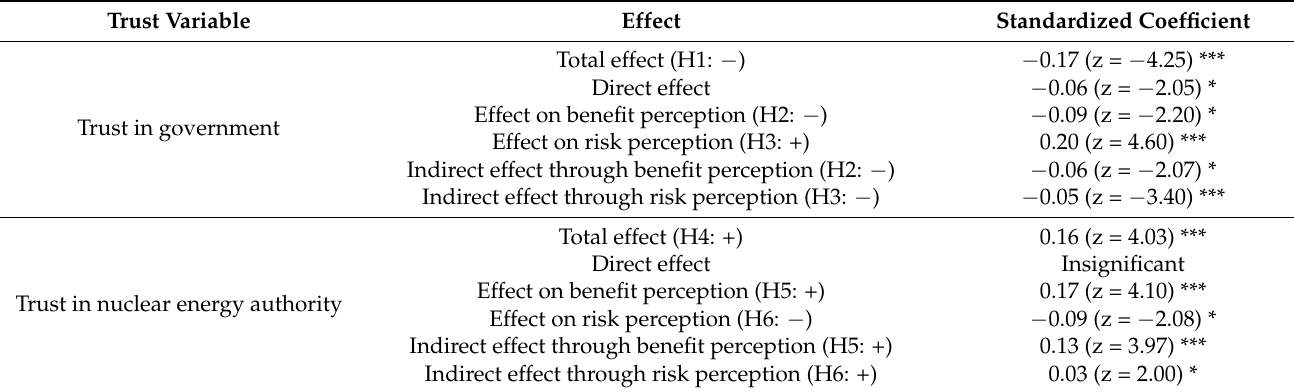
Table 4. Standardized estimates of path